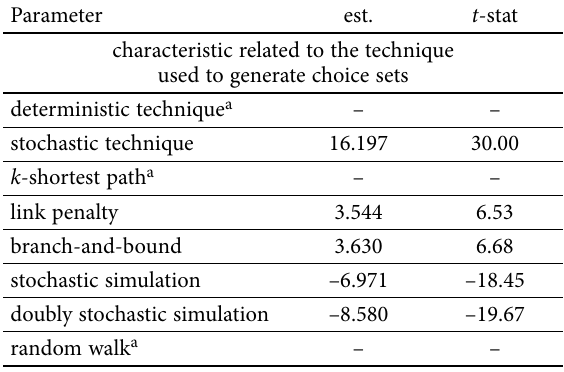
Table 6. Meta-analysis estimates of the accuracy of model